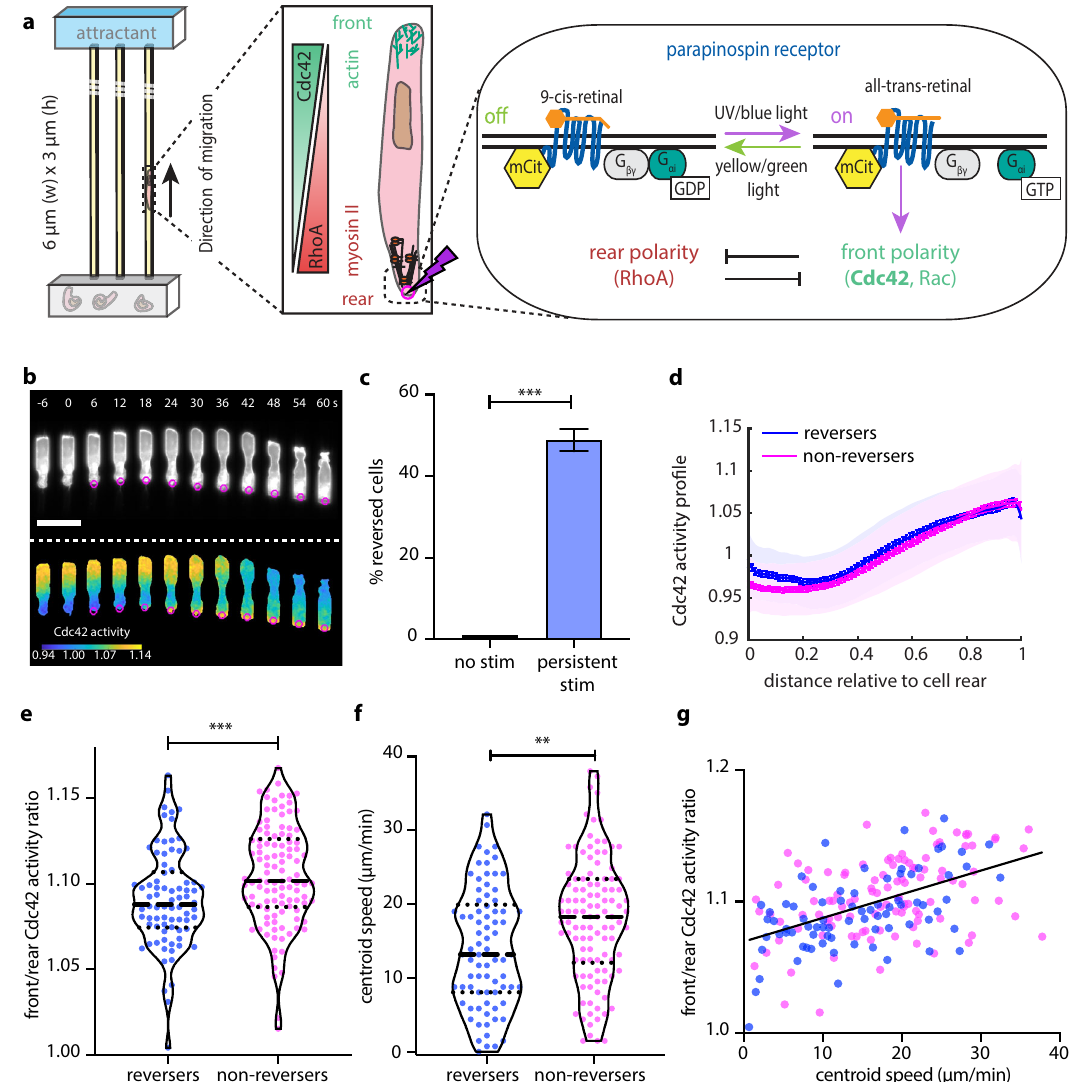
Fig. 1 Persistent optogenetic stimulation is suf fi cient to reverse weakly polarized and slowly migrating cells. a Schematic representation of the front – rear polarity reversal assay. HL60 cells expressing parapinopsin, an optogenetic receptor, migrate inside micro fl uidic devices that harbor straight channels. A heat-inactivated serum gradient is used as an attractant. The opsin can be turned on using UV/blue light and off with yellow/green light, offering complete control of the receptor activity. Blue light stimulation (magenta circle/lighting bolt) at the rear of the cell turns on the receptor. The receptor is coupled to the polarity signal transduction network and activation re-enforces the front module. b Live-cell imaging snapshots of cells expressing parapinopsin and a red/far-red Cdc42 FRET sensor. Cells migrate unperturbed for 60 s prior to initiation of persistent pulsed stimulation (magenta circles) at their rear. Upper and lower panels show the registered sensors (gray scale) and the computed Cdc42 activity, respectively. Images were captured every 3 s and subsampled for illustration purposes. Scale bar: 25 μ m. c Box plot of the percentage of cells that reversed with persistent pulsated stimulation ( n = 336 cells from 36 independent experiments) vs. non-stimulated control ( n = 32 cells from 3 independent experiments). Error bar represents con fi dence intervals assuming a binomial distribution around the cumulative mean. Two-sided Fisher ’ s exact test revealed a signi fi cant difference between the two conditions (*** p < 0.001). d Mean Cdc42 activity pro fi les for n = 78 reverser (blue) and n = 110 non-reverser (magenta) cells averaging cell pro fi les over 15 s prior to stimulation (lines: means, shaded regions: SD, error bars: mean value ± SE). e , f Violin plots of mean front/rear Cdc42 activity ratio ( e ) and of mean centroid speed ( f ) of n = 78 reverser and n = 110 non-reverser cells, averaging over 15 s prior to stimulation; p -values of two-sided Wilcoxon ’ s rank-sum test (** p < 0.01, *** p < 0.001). g Linear regression between calculated mean front/rear Cdc42 activity, shown in e , and mean centroid speed, shown in f , prior to stimulation, for n = 188 cells, yields Pearson ’ s correlation coef fi cient r = 0.502, p = 2 × 10 − 13 . Source data are provided as a Source Data fi le, including exact p